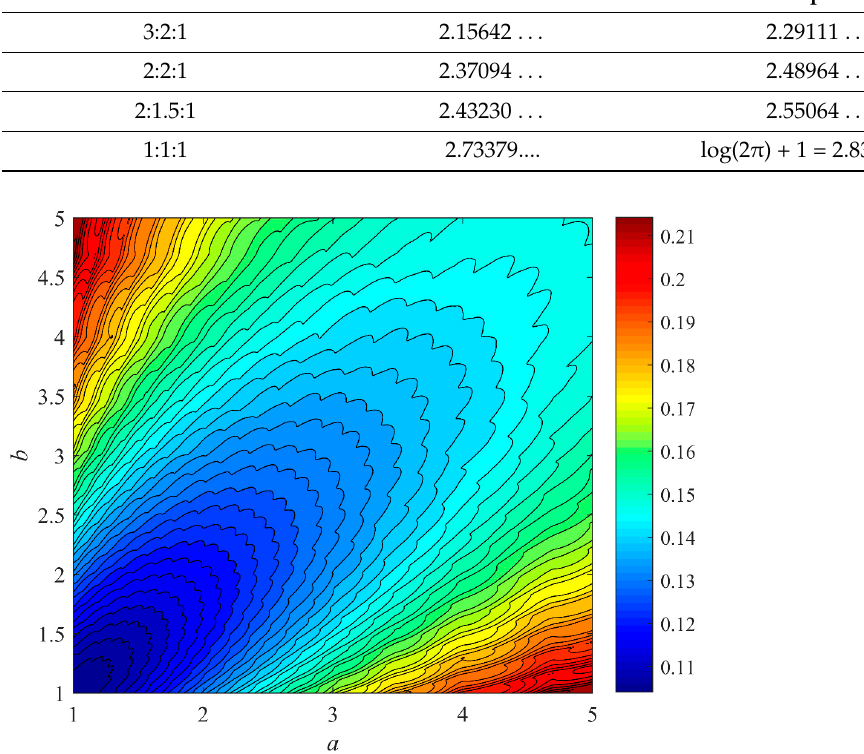
Figure 11. The differences in shape entropies of ellipsoids and cuboids with different axial length